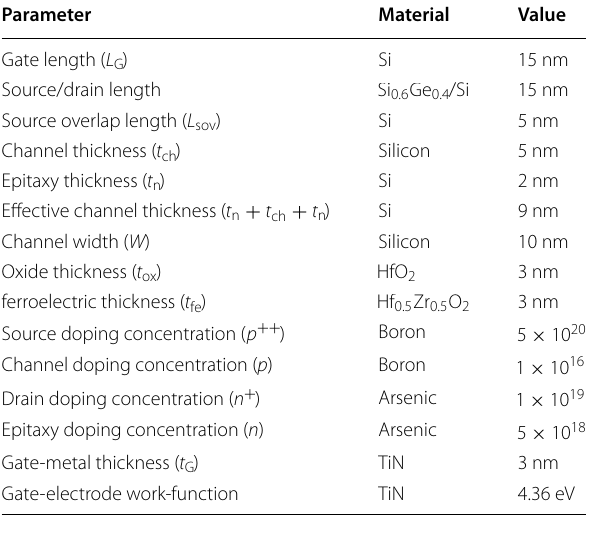
Table 1 Device design specifications and materials